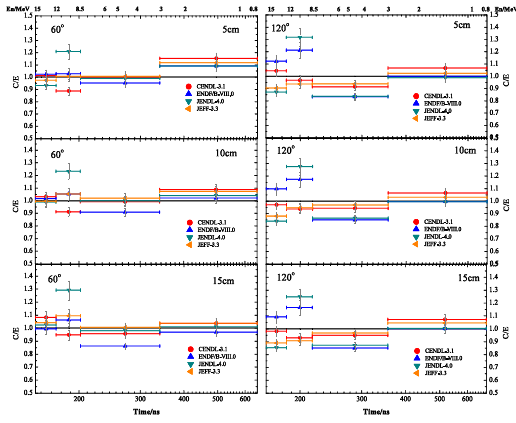
Fig.9 The comparison of measured and calculated leakage neutron spectra from iron sample （ 30 cm×30 cm ） .